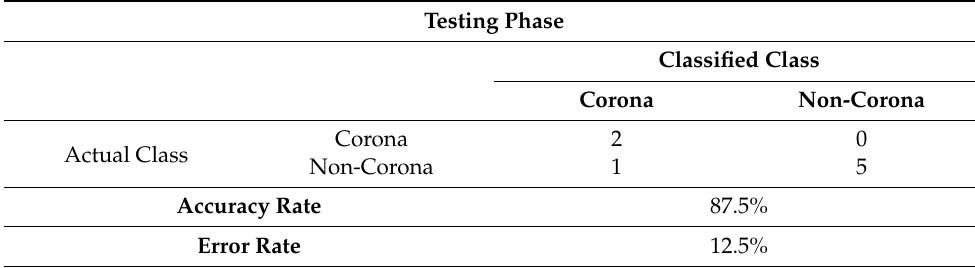
Table 13. Confusion matrix for testing phase—frequency domain corona fault